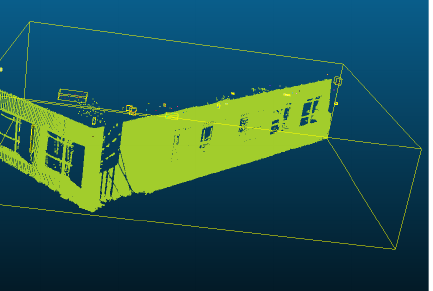
Figure 9: Left; segments obtained by connected component anal- ysis. Right; Largest segment is selected as the object of interest and the other segments are